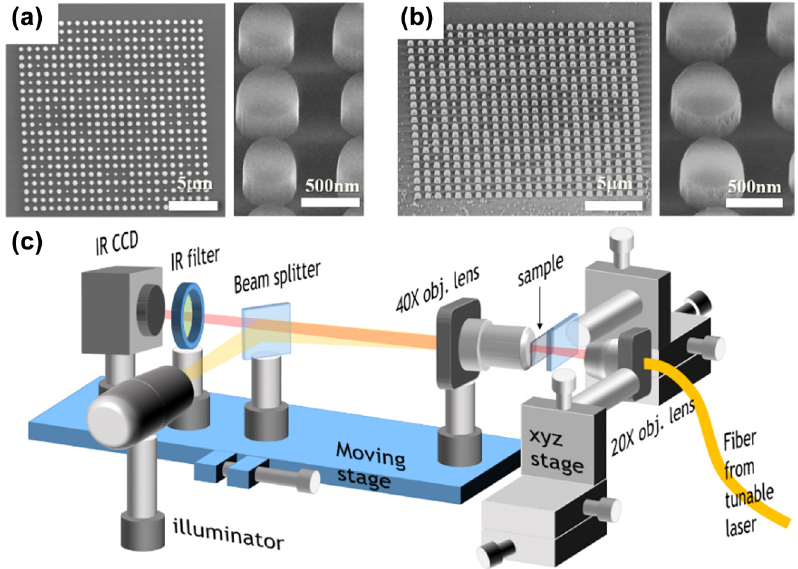
Figure 3: SEM images of the fabricated metalenssampleswith(a)thick(140 nm)and (b)thin(100 nm)ma-Nlayersfora10 μ mfocal length. (c) Schematic of the experimental